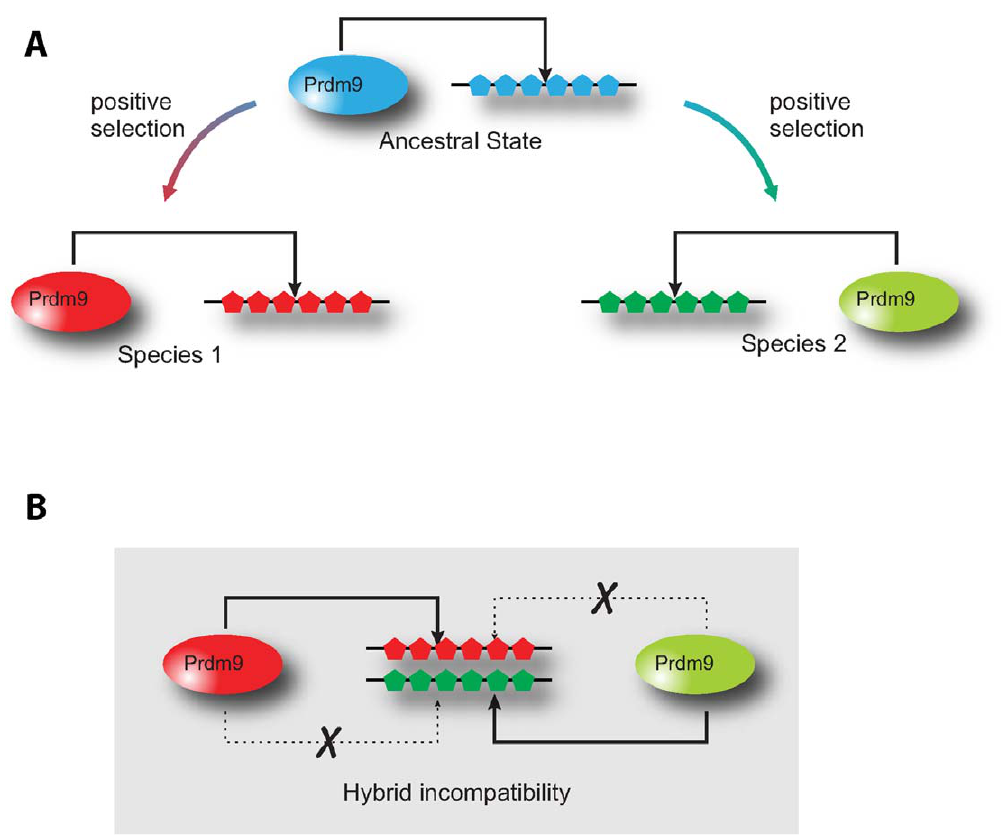
Figure 7. A novel satellite–DNA binding model for Prdm9 in hybrid sterility. (A) Prdm9 could serve as a satellite-DNA binding protein that facilitates its heterochromatinization. Hybrid sterility ensues when the sterility-associated Prdm9 protein (blue) cannot bind to ‘‘newly expanded’’ satellite DNA repeats (red or green) potentially at pericentric regions of chromosomes that arose due to centromere-drive [63]. (B) Under this model, in isolated populations, satellite–DNAs diverge quickly by ‘‘centromere-drive’’ and Prdm9 DNA–binding specificity evolves rapidly to suppress this drive. However, in hybrid males, inappropriate localization of Prdm9 to diverged DNA–binding satellites from other species would result in either inappropriate chromosome condensation (as shown) or compromised centromere function (not shown), either of which would result in male sterility.